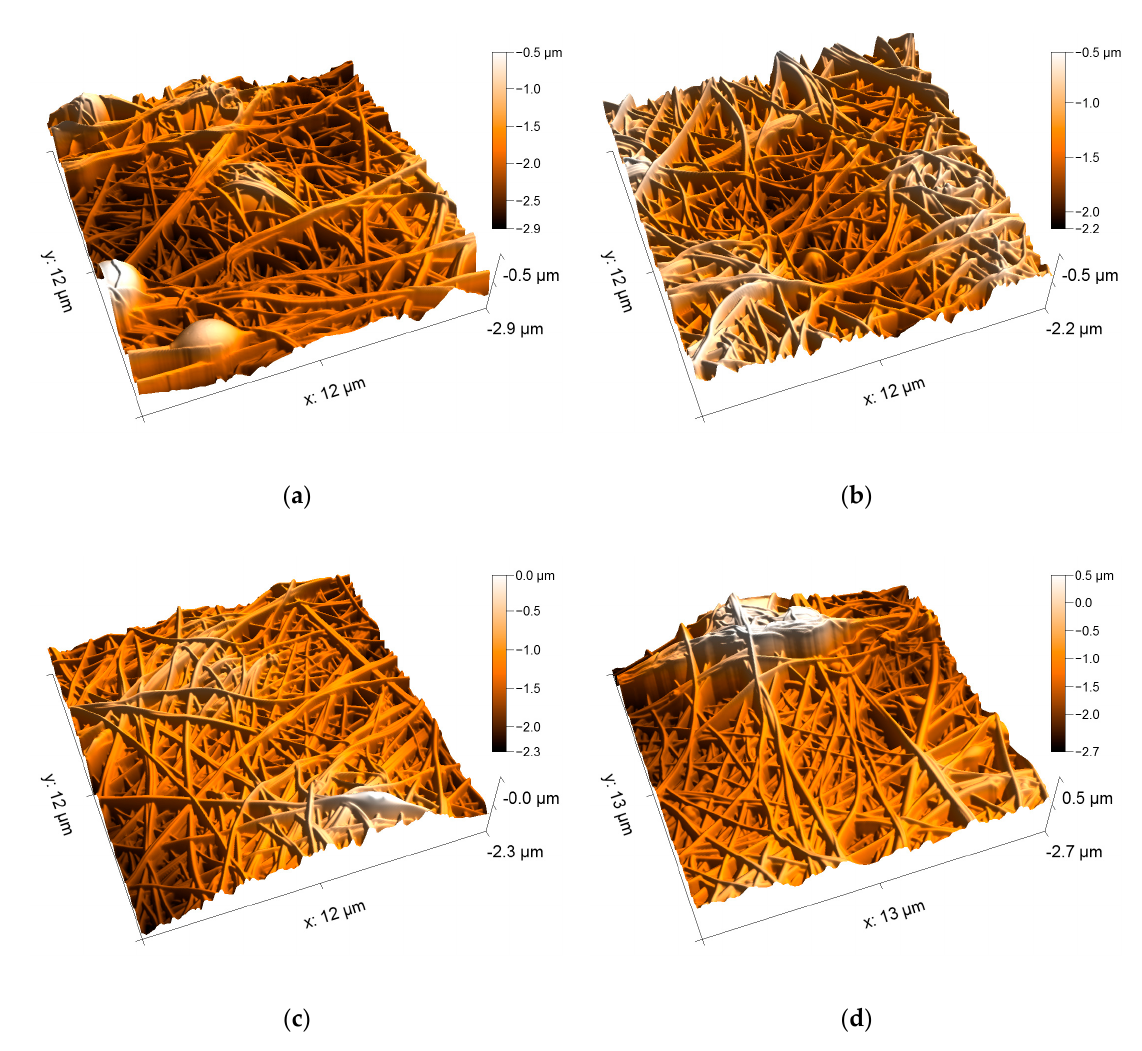
Figure 8. AFM images of the PAN/magnetite nanofiber mats with different polymer:nanoparticle weight ratios: ( a ) 1:0.38; ( b ) 1:0.79; ( c ) 1:1.25; ( d ) weight ratios: ( a ) 1:0.38; ( b ) 1:0.79; ( c ) 1:1.25; ( d ) 1:1.8.